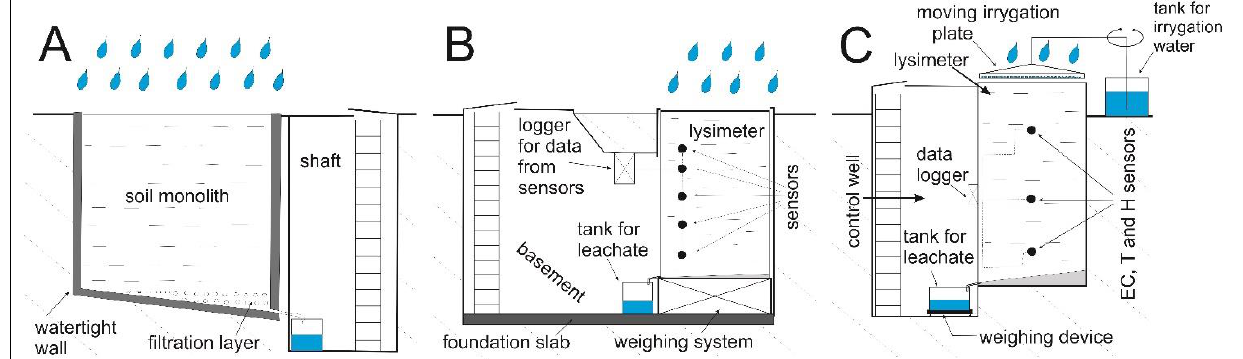
Fig. 1. Examples of lysimeter